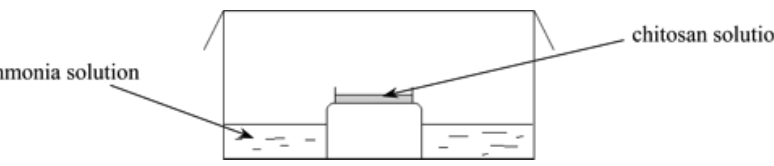
Figure 2. Experimental setup for the gelation of chitosan solutions by using gaseous ammonia atmosphere. Adapted with permission from [31], Copyright 2005 American Chemical Society.